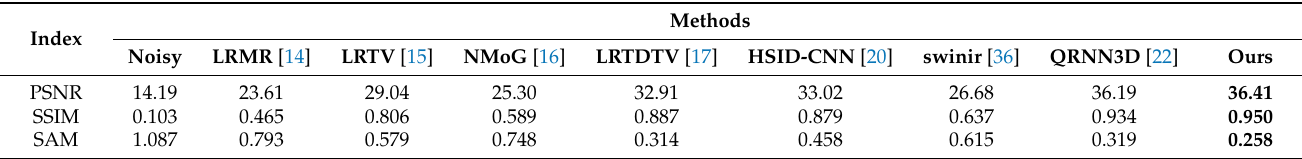
Table 4. The denoising results in the complex noise case on the CAVE dataset.